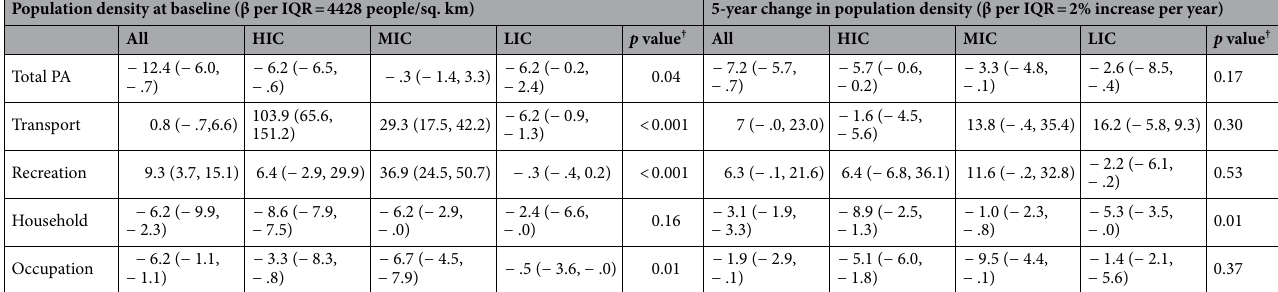
Table 3. Associations between community population density at baseline, and 5-year population density change prior to baseline, and individual-level physical activity. Adjusted Model: Age, sex, baseline year, education, wealth index, country income level, chronic disease at baseline, BMI, and nested random intercept for each community by center. Change model includes baseline population density. † p value for interaction between country income level and each urbanization metric. # β coefficients represent percent change in MET minutes per week of total or domain specific physical